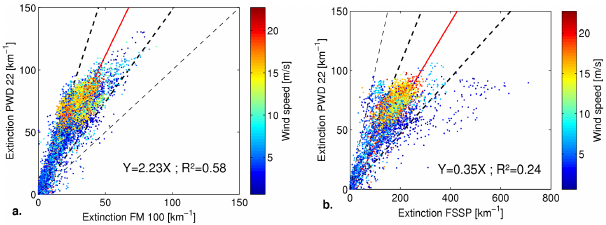
Figure 10. One minute averaged (a) FSSP and (b) FM-100 extinc- tions vs. the PWD extinction during the entire ROSEA campaign. The measurements have been selected for cloudy events. The red line reveals the linear correlation and the color bar shows the values of the wind speed. The bold dashed lines show the instrumental er- rors applied to the fit. The 99% confidence interval of the FM slope value was estimated to be [2.197,